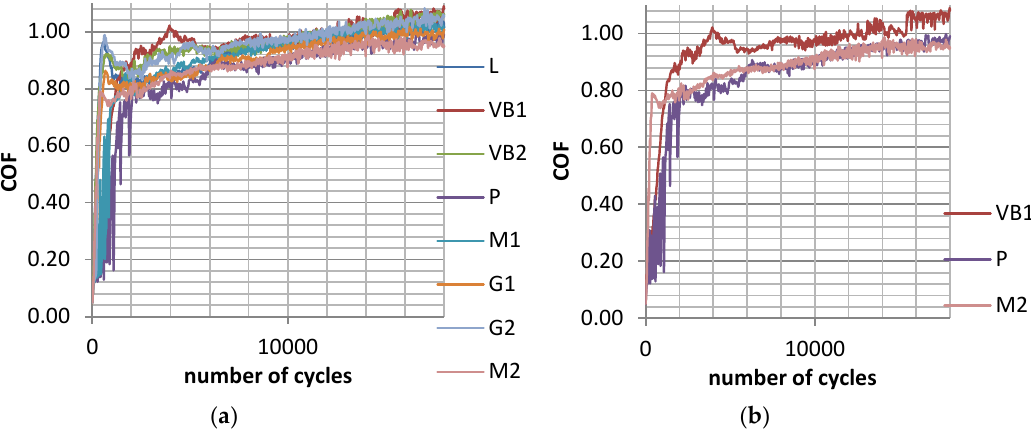
Figure 4. Maximum coefficient of friction during test C for assemblies with all ( a ) and selected discs after vapour blasting VB1, after lapping L and after milling M2 ( b ) for the following operating parameters: s = 0.1 mm, P = 45 N, f = 20 Hz.